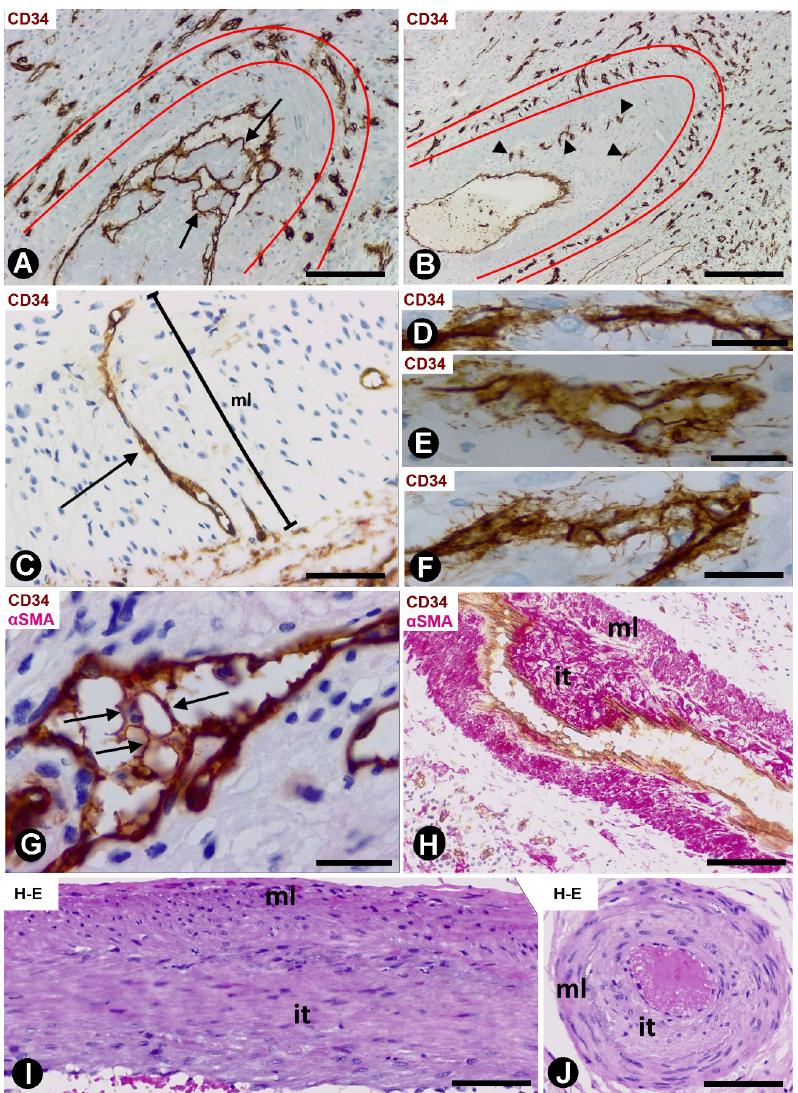
Figure 4. Arteries in gallbladders with acute cholecystitis and delay cholecystectomy. Sections immunostained with anti-CD34 ( A – F ), double-immunostained with anti-CD34 (brown) and α SMA (red) ( G , H ) and stained with HE ( I , J ). ( A , B ) arteries with numerous residual microvessels (delimited between red lines) in the adventitia. Some large pillars are observed in A (arrows) and residual microvessels (arrowheads) underlying the elastic interna in B. ( C ) A residual microvessel (arrow) is shown crossing the entire thickness of the arterial wall from the adventitia to the intimal thickening. ( D – F ) Numerous CD34+ filopodia-like are observed in ECs of some microvessels. ( G ) Intravascular bridges in residual vessels (arrows). ( H – J ) Presence of well-formed intimal thickening (it) (arterial media layer: ml). Bar: ( A , B , H ): 160 µ m; ( C ): 80 µ m; ( G ): 20 µ m; ( D – F ): 10 µ m; ( I , J ): 60 µ